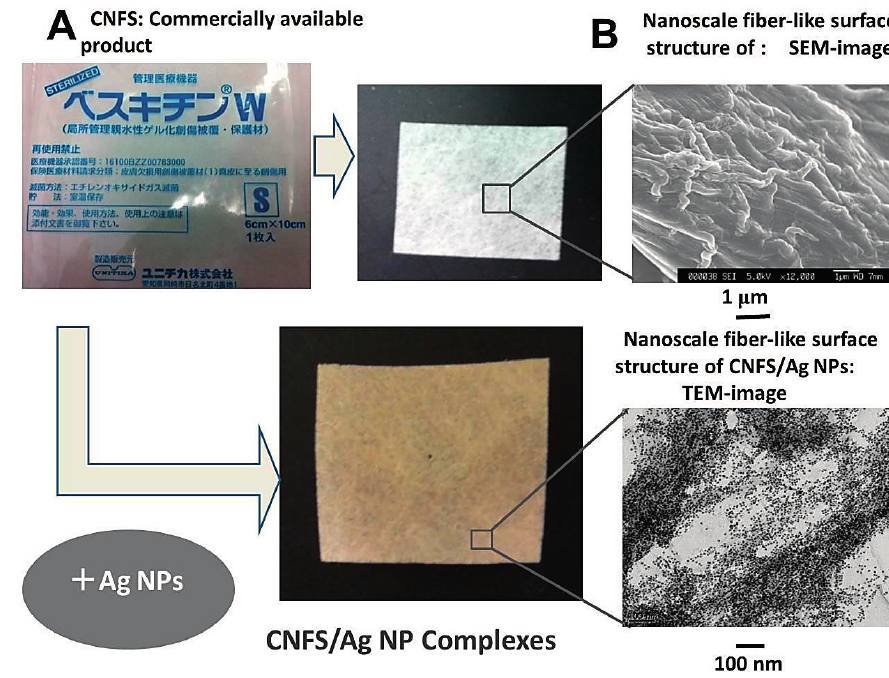
Figure 7. Production ( A ) and appearances ( B ) of chitin nanofiber sheet (CNFS)-Ag NP complexes.